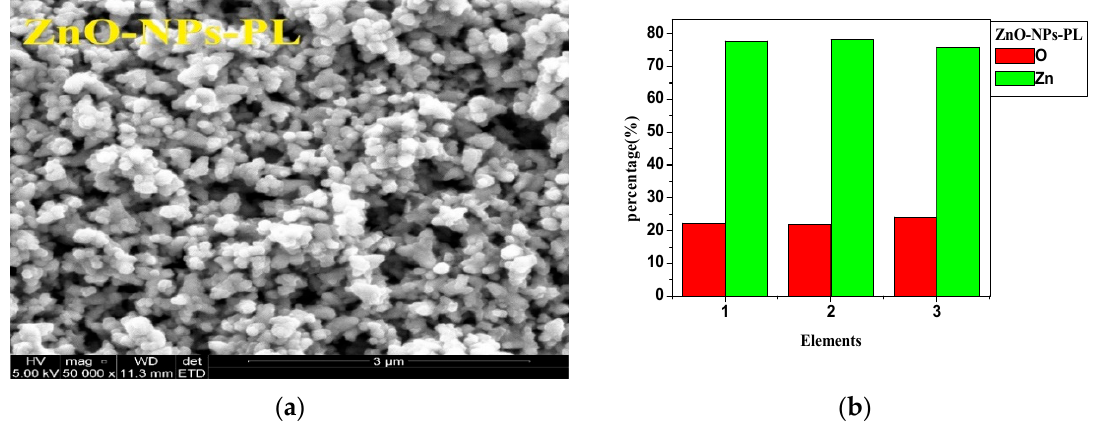
Figure 8. ( a ) SEM image of pomegranate leaf-mediated zinc oxide nanoparticles. ( b ) EDX spectrum of pomegranate leaf-mediated zinc oxide nanoparticles.